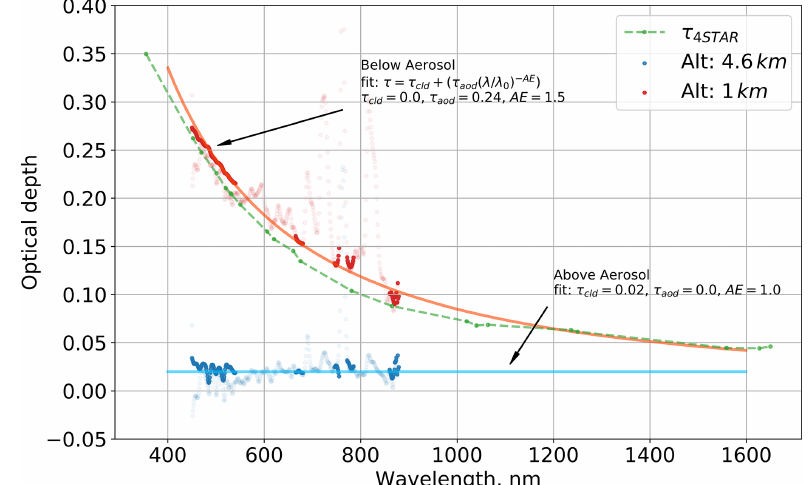
Figure 4. Two examples of the spectral optical depth used in RS to determine τ cld and τ aer . Both examples are from the spiral on 5 October 2018 of the ORACLES mission. (1) A clear-sky case, colored in blue, from a sample taken at an altitude 4.6km. (2) In red, a sample from 1km, which is below the aerosol layer. The dark red and blue dots are τ adj ,λ , and they correspond to the dashed red and blue lines in Fig. 1. The faded red and blue dots are τ λ = τ tot ,λ − τ Ray ,λ values from all SPN-S channels from 460 to 880nm, including those not used in the retrieval. The blue and red lines represent the best-fit lines for the RS outputs. The green line is τ 4STAR as measured at 1km altitude.